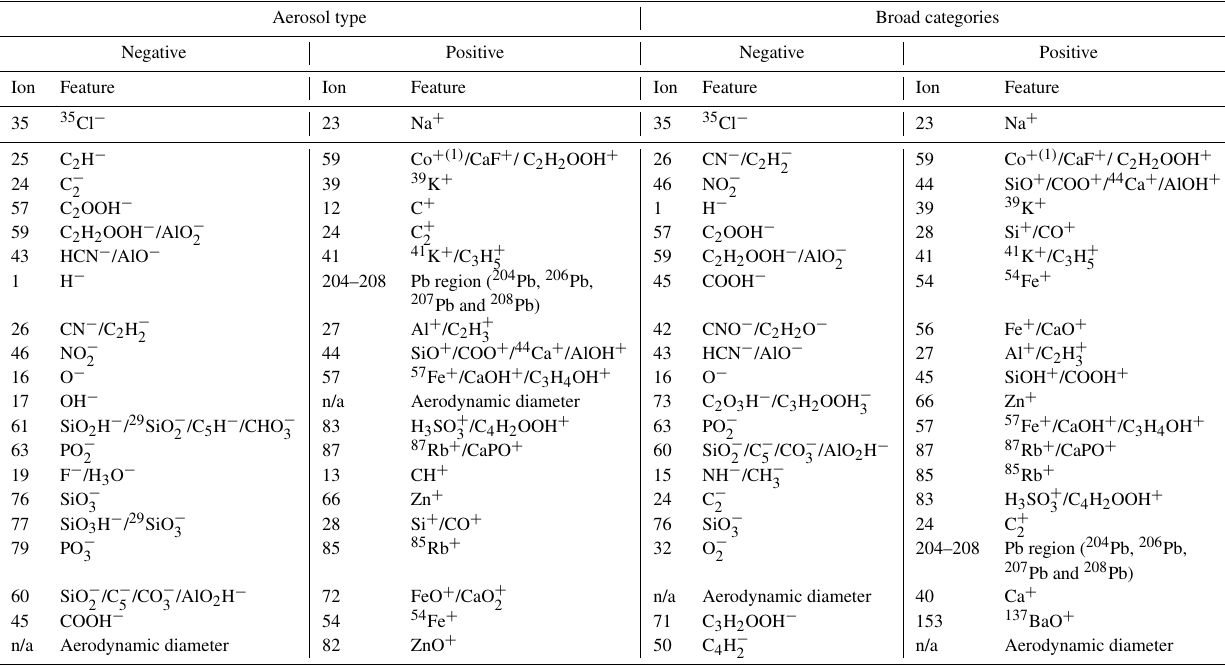
Table 2. Features rankings for differentiation of particles between labels and between broad categories in positive and negative ion modes. See text for additional details. “n/a” stands for not